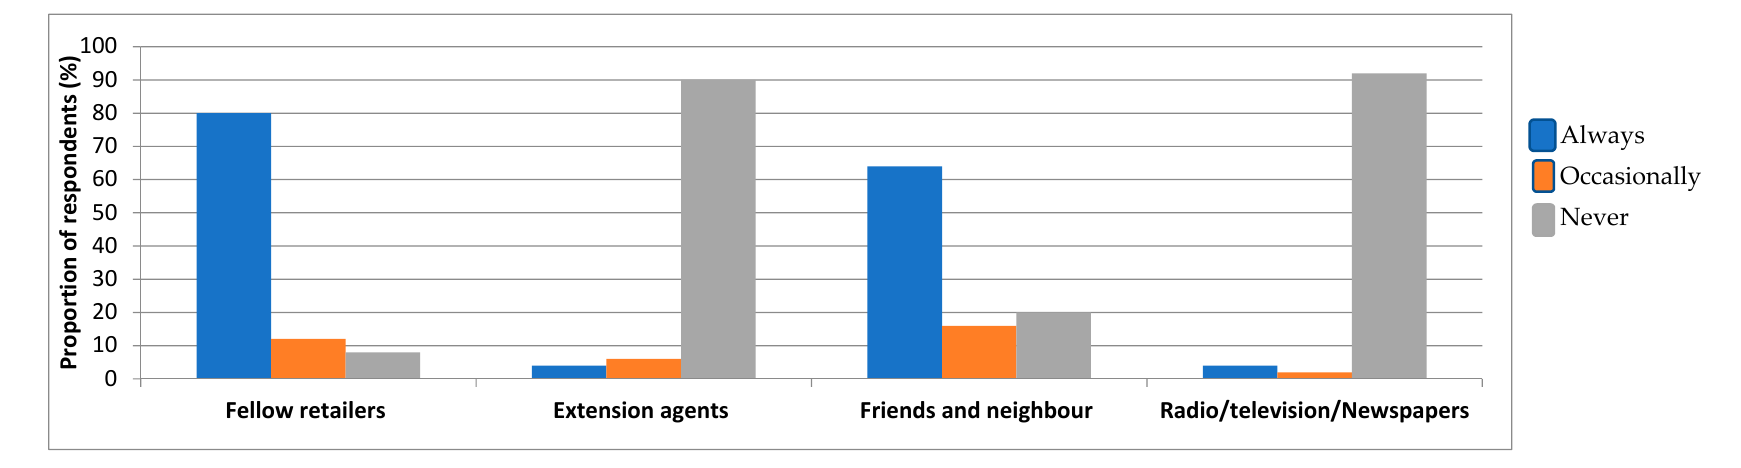
Figure 4. Retailers’ sources of information on post ‐ harvest practices ( n = 50).